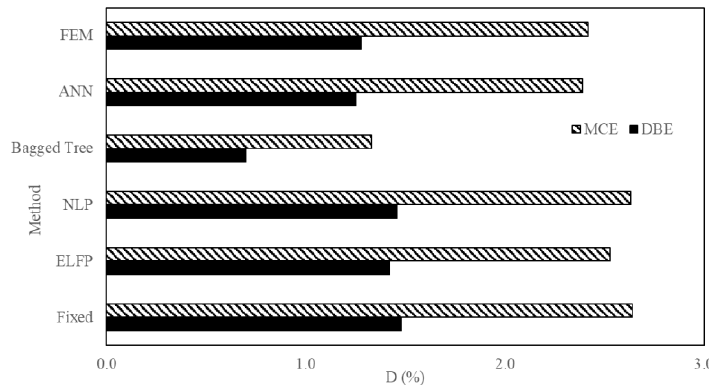
Figure 20. Comparison of base shear obtained from different techniques.